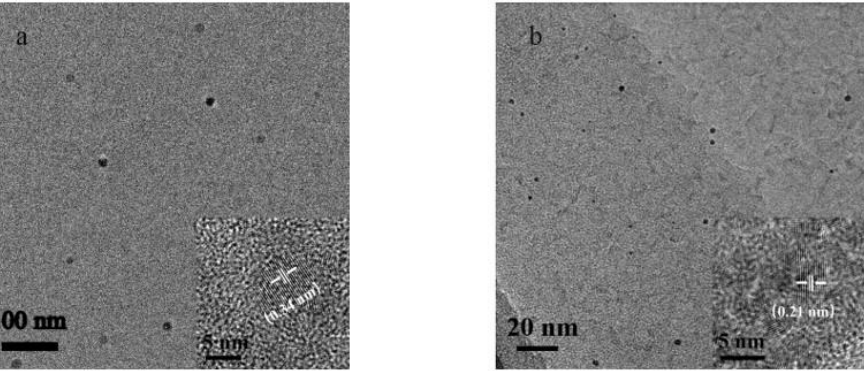
Figure 1. TEM images of CdTe QDs ( a ) and C QDs ( b ). Inset: High-resolution TEM images of corresponding nanomaterials.